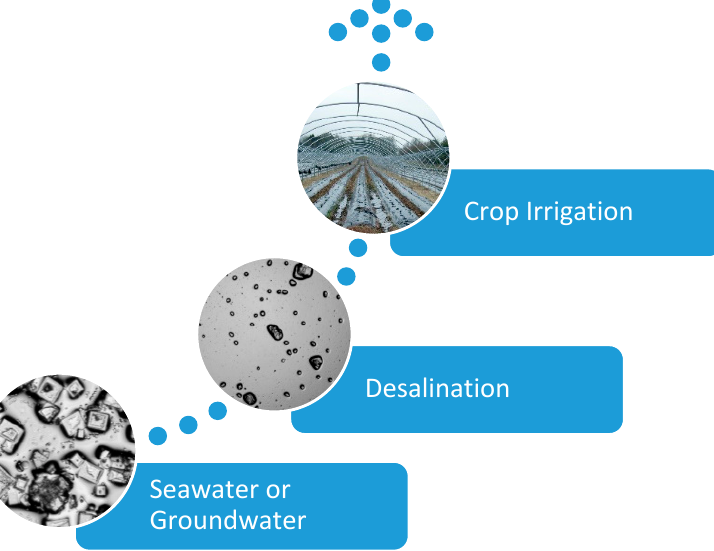
Figure 1. The desalination process flow from seawater (or saline groundwater) to a desalination reactor, producing partially desalinated water, prior to use for irrigation. Photomicrographs are of evaporated water. The crystals are NaCl.